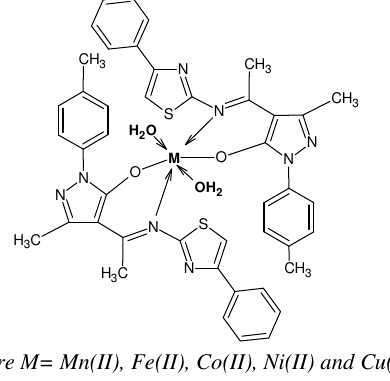
Figure 1. Metal complexes of